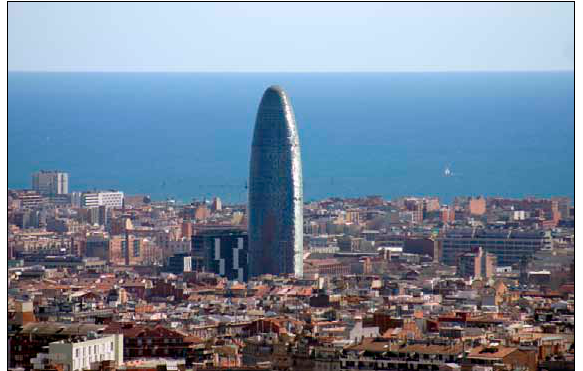
fig. 3. agbar Tower,